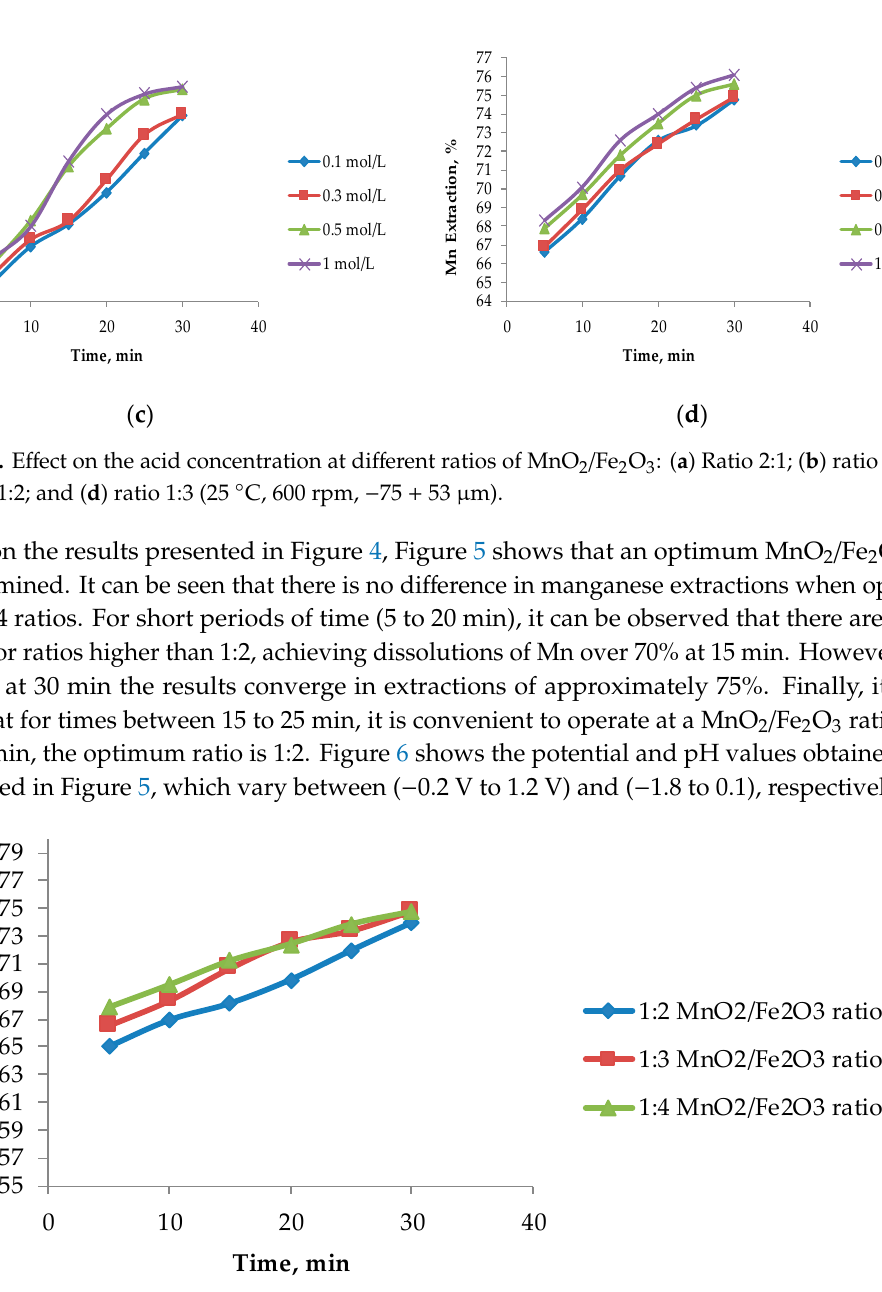
Figure 5. Effect of the MnO 2 /Fe 2 O 3 ratio on manganese extraction (25 °C, 600 rpm, − 75 + 53 μ m, acid concentration of 0.1 mol/L).